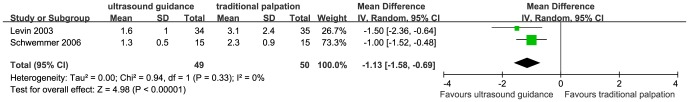
The forest plot depicting mean-attempts to success.